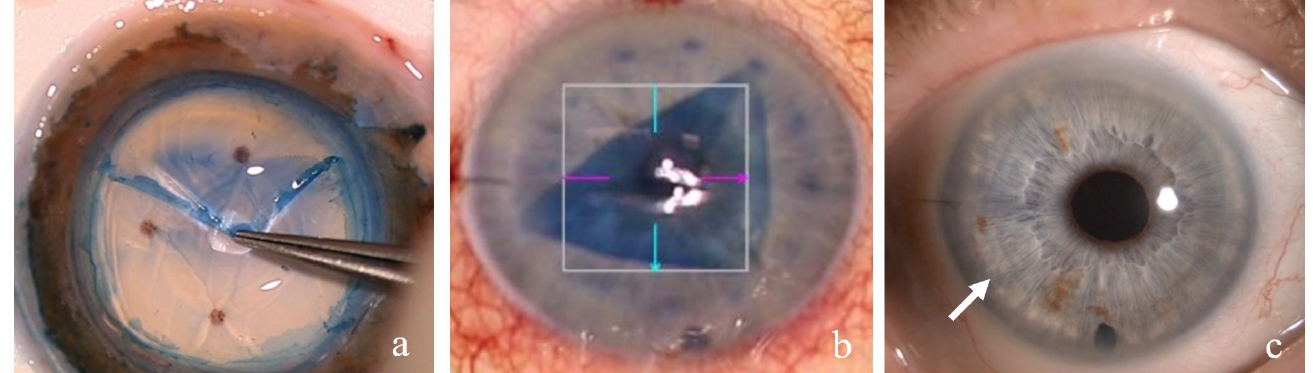
Figure 2. Endothelial corneal transplantation DMEK — Descemet membrane endothelial kerato- plasty: ( a ) photograph of the preparation of the DMEK transplant — the Descemet membrane is stained with trypan blue and detached by a gentle forceps pull at the periphery; ( b ) intraoperative view of the anterior chamber with a partially bent trypan blue-stained DMEK transplant in the center of the anterior chamber; ( c ) photograph of the anterior chamber in a 67-year-old female patient 1 month after DMEK — the cornea is clear and transparent, and the peripheral border of the DMEK transplant can be observed (arrow).